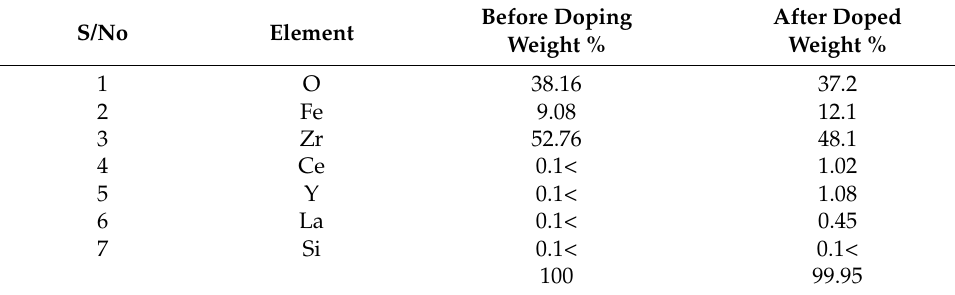
Table 6. Elemental composition of Fe 3 O 4 @mZrO 2 -Re (Re = Y/La/Ce).